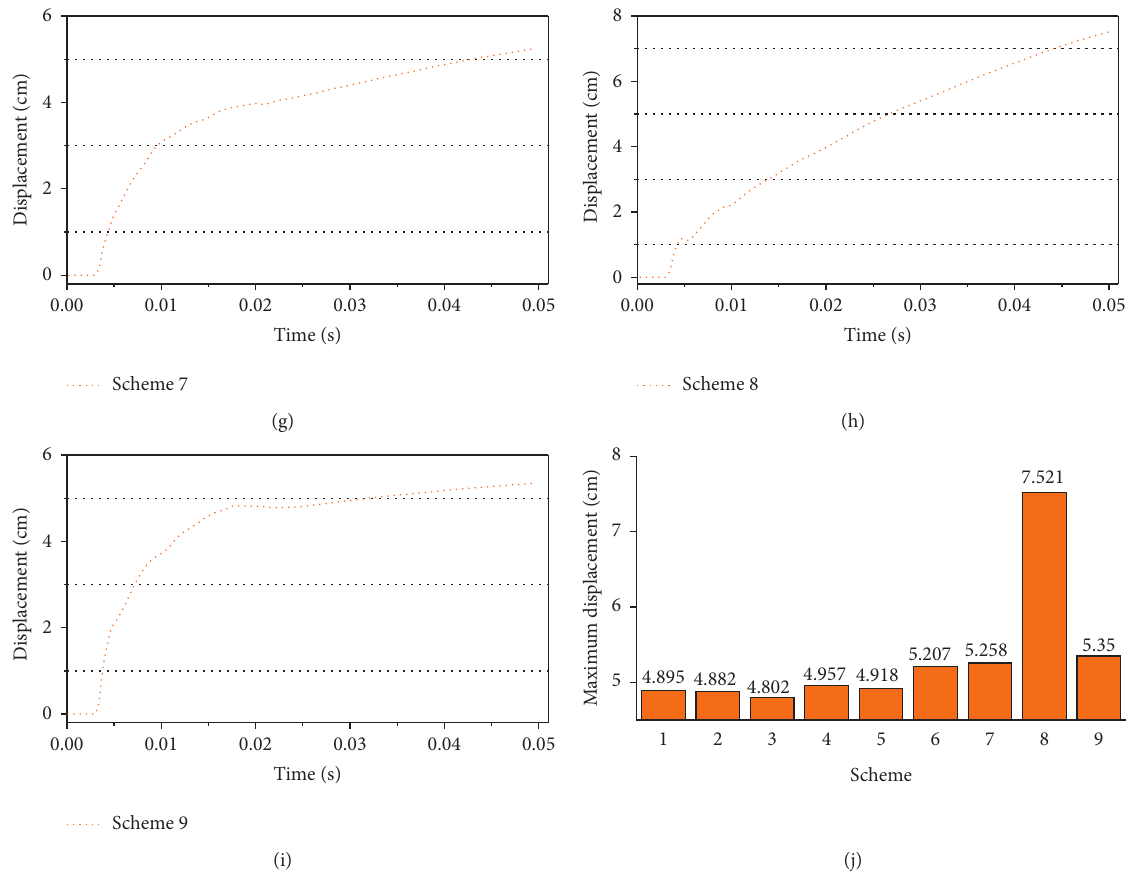
Figure 4: Bench back-pulling situation diagram. (a)–(i) Displacement monitoring curve under 9 schemes. (j) Statistics of the maximum displacement under 9 schemes. (a)Displacement monitoring curve of scheme 1. (b) Displacement monitoring curve of scheme 2. (c)Displacement monitoring curve of scheme 3. (d) Displacement monitoring curve of scheme 4. (e)Displacement monitoring curve of scheme 5. (f) Displacement monitoring curve of scheme 6. (g)Displacement monitoring curve of scheme 7. (h) Displacement monitoring curve of scheme 8. (i)Displacement monitoring curve of scheme 9. (j) Statistics of the maximum Table 6: Blasting effect calculation.